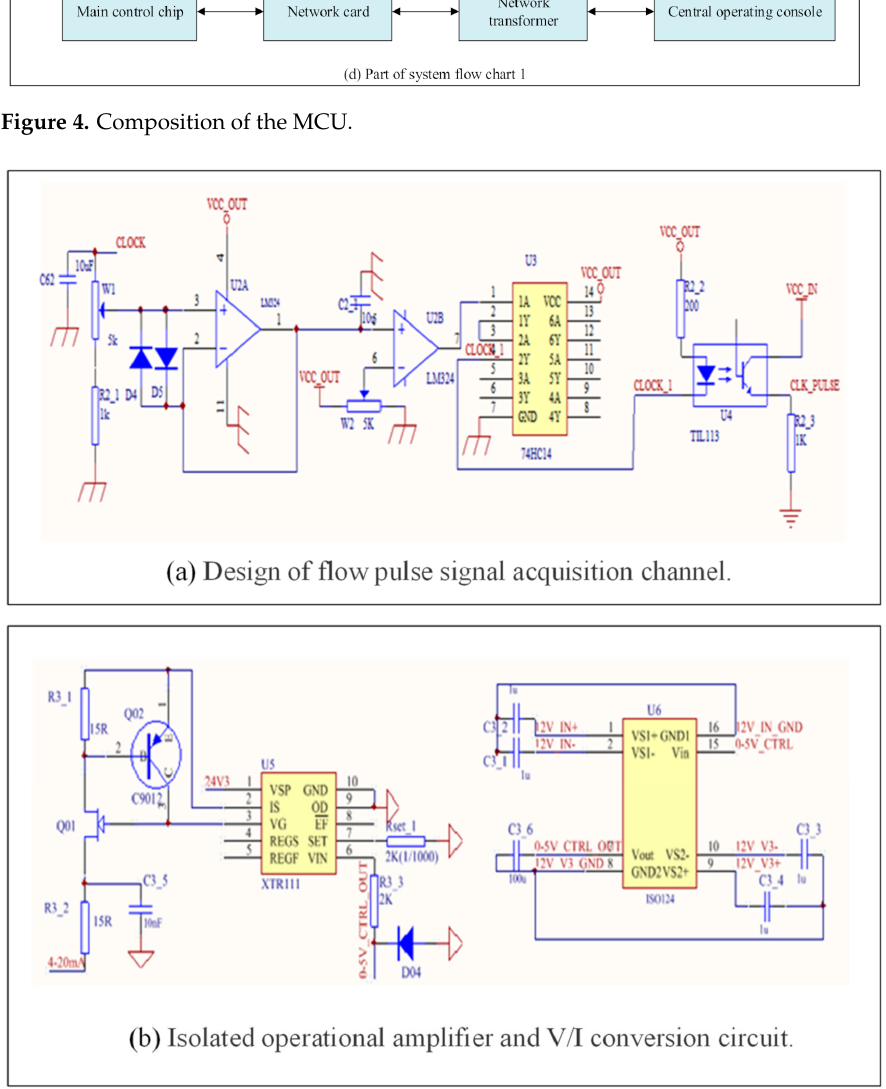
Figure 5. Composition of the MCU